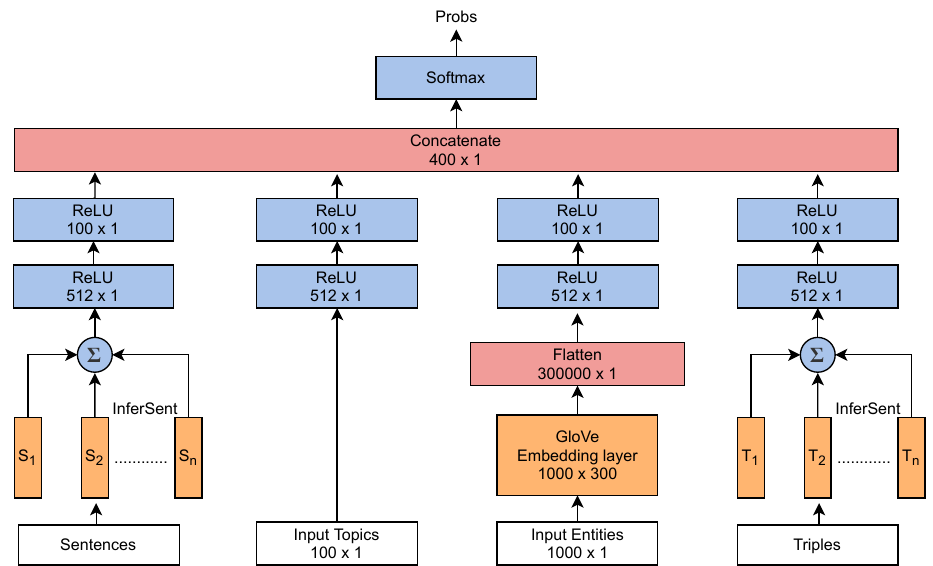
Figure 4. Deep learning architecture for classification of news-feeds using sentence embeddings of text and triples, topics, and named